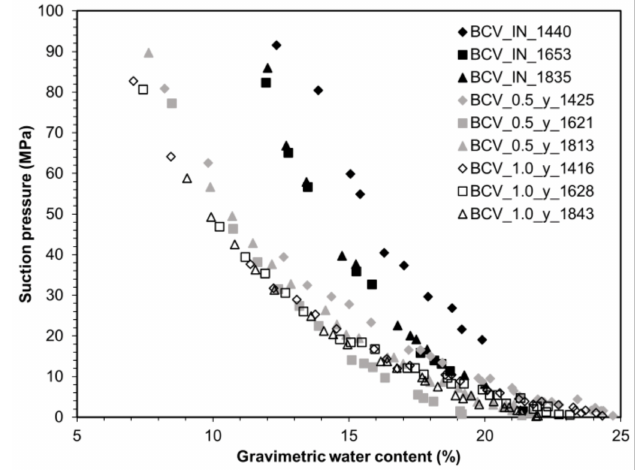
Figure 5. Water retention curves of compacted bentonite samples at given dry density (kg/m 3 ).